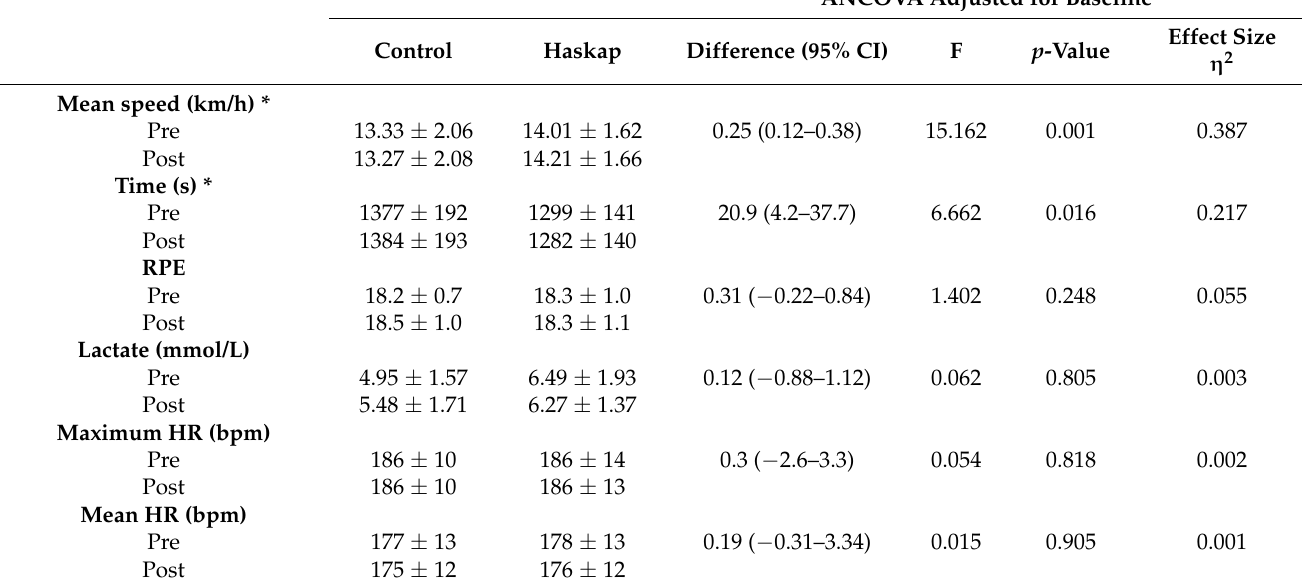
Table 5. Data from the 5 km time trial (TT) before and after the intervention of Haskap or placebo con-